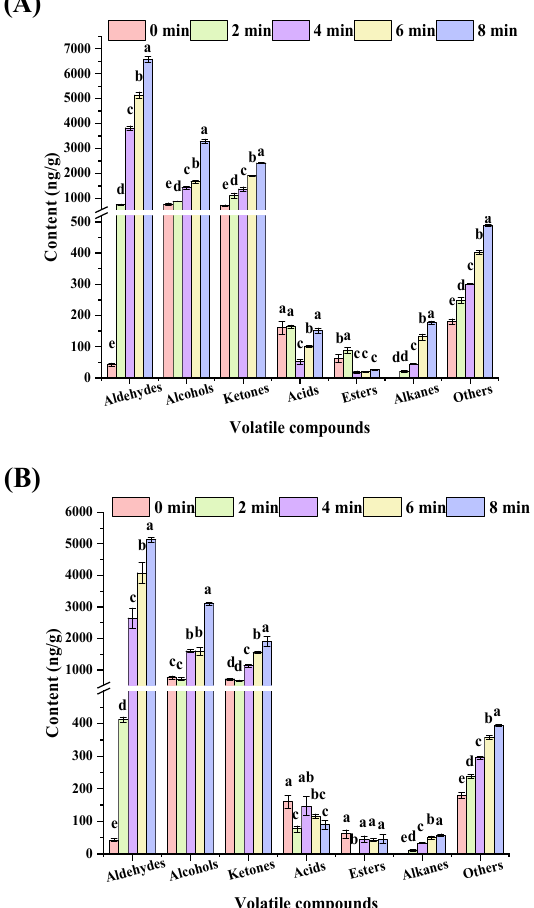
Figure 3. Profiles of volatile compounds in tamarix lamb roasted by charcoal ( A ) or electric ( B ). Different lowercase letters indicate that there is significant difference ( p < 0.05).